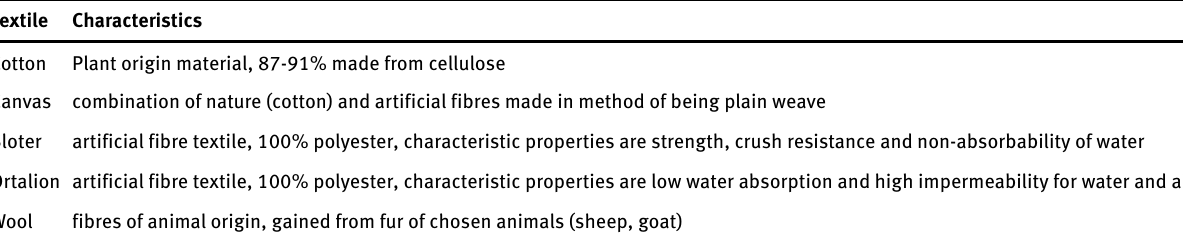
Table 1 : List of used textile samples and their definition Textile